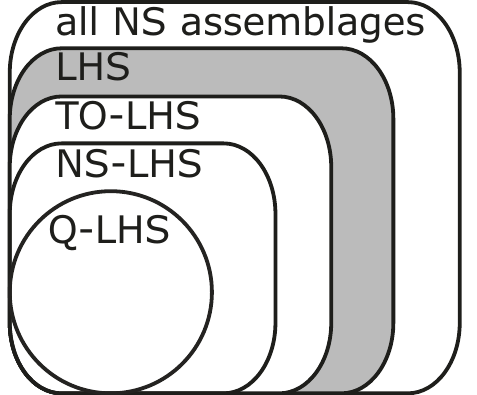
Fig. 3 Pictorial representation of inner structure of the set of all non-signaling assemblages in the tripartite scenario. Inclusion is strict for all depicted subsets: the set LHS of generic local-hidden- state (LHS) assemblages, the set TO-LHS of time-ordered LHS ones, the set NS-LHS of non-signaling LHS ones, and the set Q-LHS of quantum-LHS ones (see Supplementary Note C for details). The shaded region represents the set of assemblages with subtle steering. Bilocal wirings can expose such steering by mapping that region to the set of (bipartite) steerable assemblages.